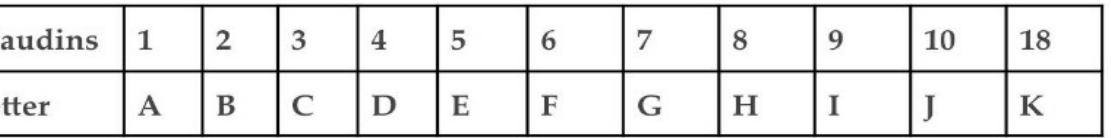
Figure 3. Reconstructed heatmap with graph prism showing Claudin protein expressions as biomarkers for cellular differentiation and indicators for phenotypic expression of the epithelia from several research studies [26–41]. Claudin protein expression patterns in varying cancer types can therefore provide information for cancer identification.